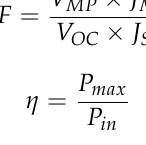
Table 1. Simulation parameters for Sb 2 Se 3 -/CdS-/ITO-based solar structure. Parameters